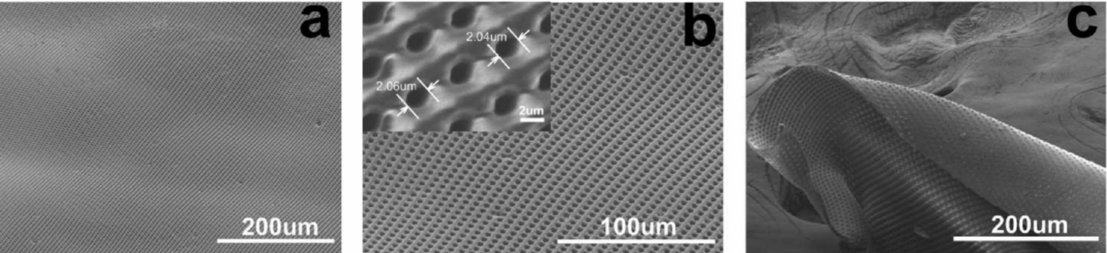
Figure 7. SEM images of ( a , b ) the obtained membrane with a well-distributed ordered cylindrical straight through-pore structure (pore size: 2 µ m, distance between adjacent pores: 2 µ m) in a large area from the imprint process, and ( c ) the bending of the membrane edge for clearly observing the through-pores. Provided with permission from IOPScience